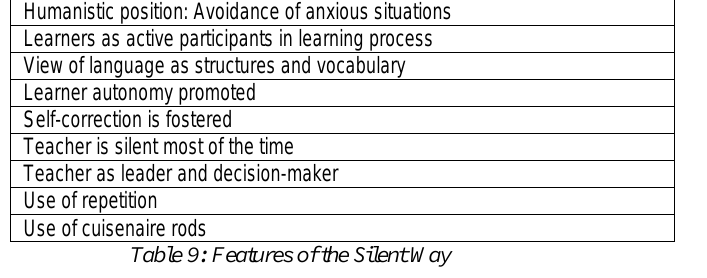
Table 9: Features of the Silent